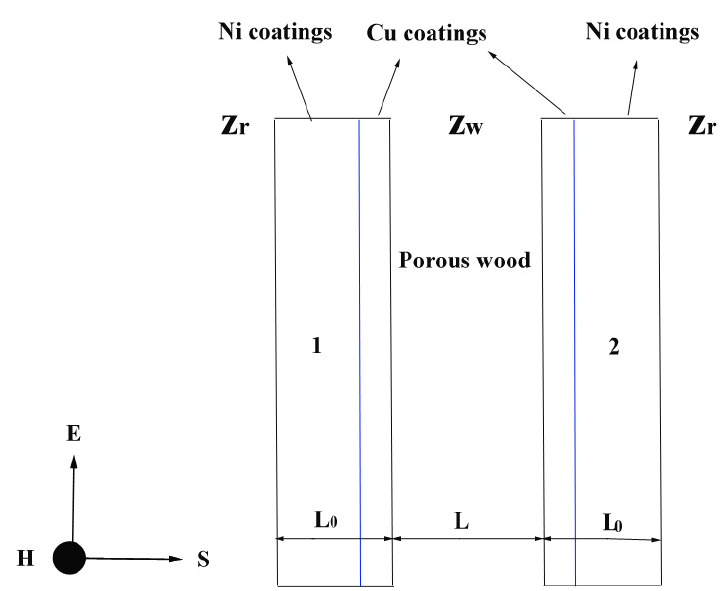
Figure 10. Schematic diagram of double shielding with an interval ( E electric field distribution, S electromagnetic wave direction of propagation, H magnetic field distribution, Zr impedance of free space, Zw wave impedance of wood, L 0 coatings thickness, L substrate thickness) [46], 1 and 2 composite coatings.